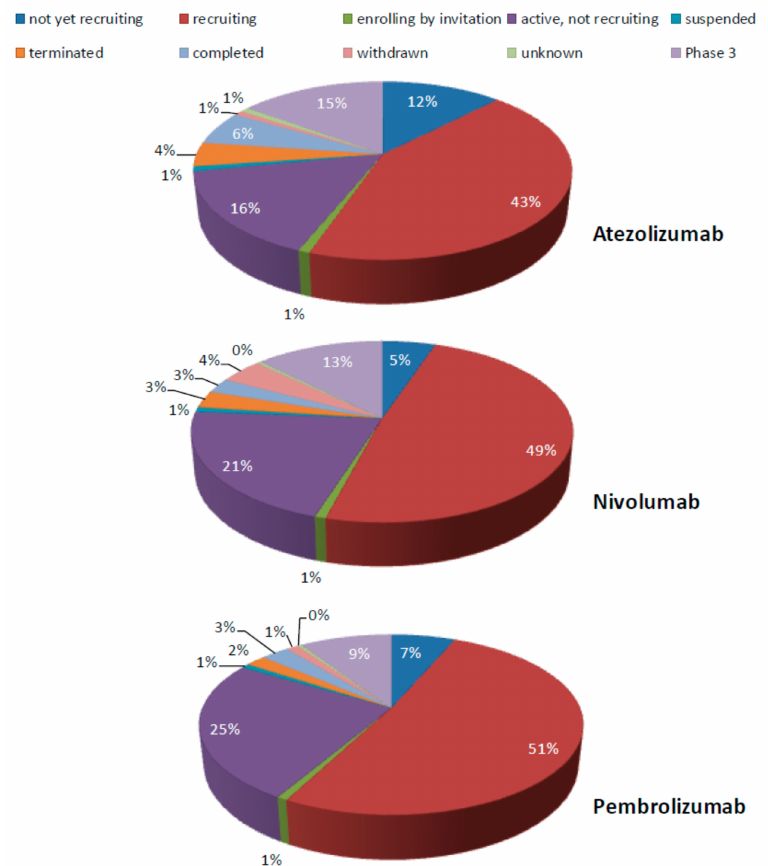
Figure 1. Overview of listed clinical trials for Atezolizumab, Nivolumab, and Pembrolizumab in lung cancer (data based on